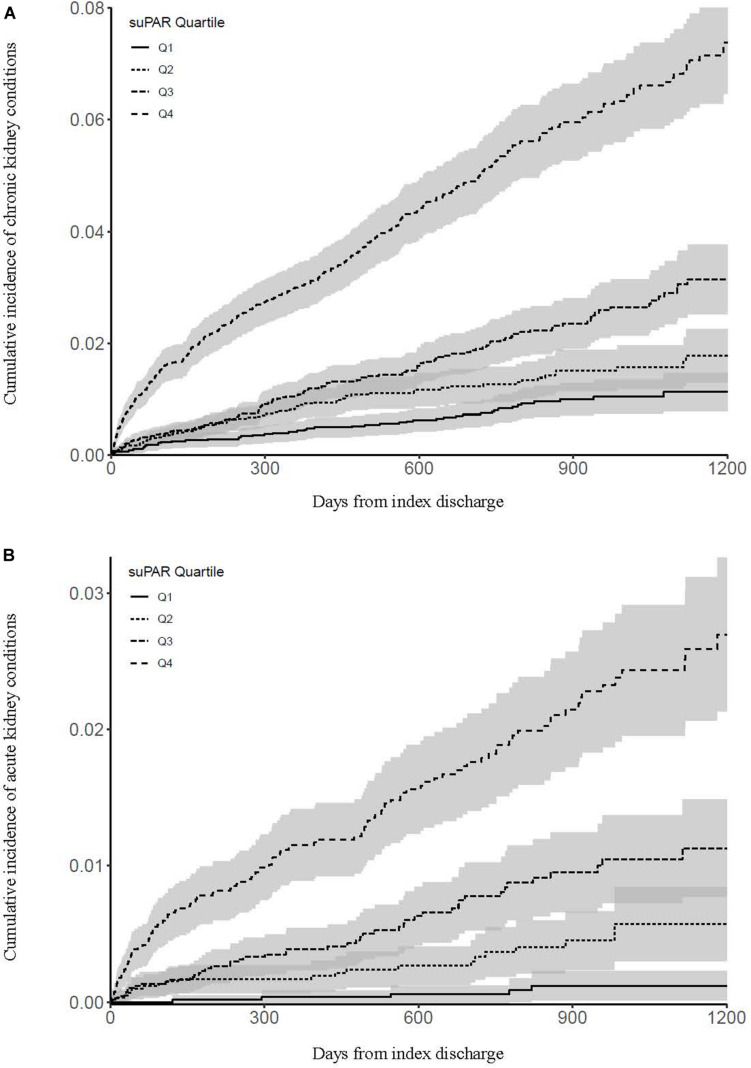
Cumulative incidence of chronic kidney conditions (A) and acute kidney conditions (B) by suPAR quartile. Shaded areas indicate 95% confidence intervals.